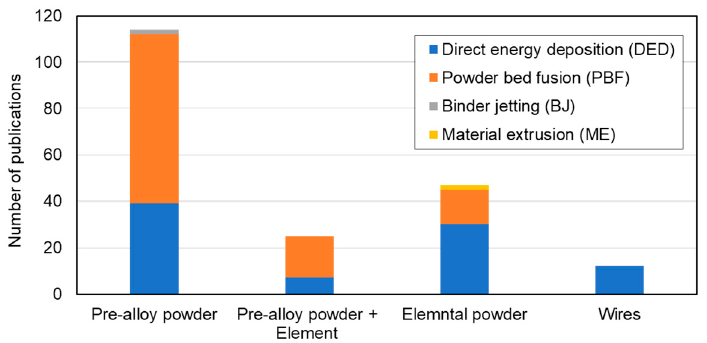
Figure 5. Number of publications related to AM of HEAs using pre-alloyed powder and mix elemental powder by various printing processes.